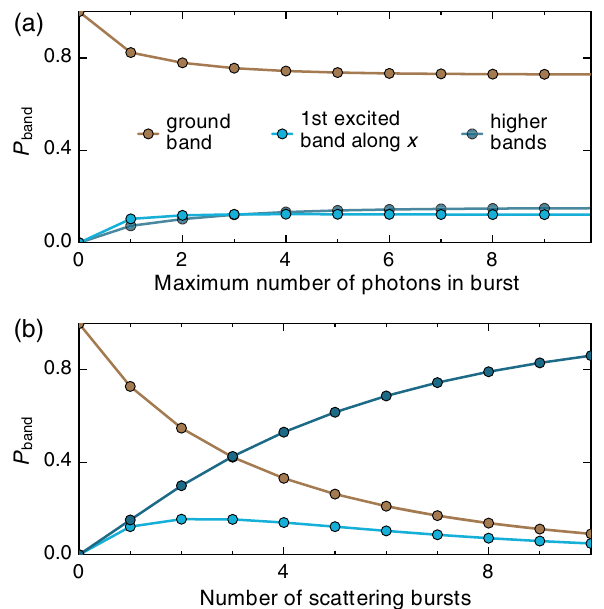
FIG. 6. Band-excitation probabilities. (a) As a function of the maximum possible number of individual photons considered in a scattering burst. We plot the integrated band-excitation proba- bility for bursts with up to n photons. This integral quickly converges to the average band-excitation probability of a scatter- ing burst. (b) Excitation probability as a function of the number of scattering bursts. The probability of staying in the ground band steadily decreases, while the probability of higher bands, which get lost, increases. At intermediate numbers of scattering bursts, a finite population of atoms builds up in the first longitudinally excited band, which is trapped. Time traces used to extract the imbalance decay rate in this work usually contain up to 10 scattering bursts per particle.